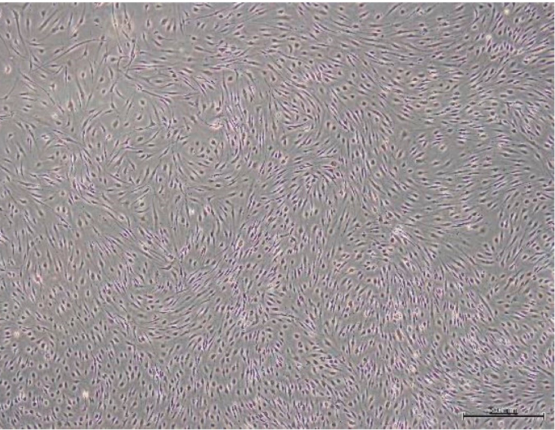
Figure 1. Cells morphology from SPFP tissue at 21st day of 1st passage under light microscope (4 ×